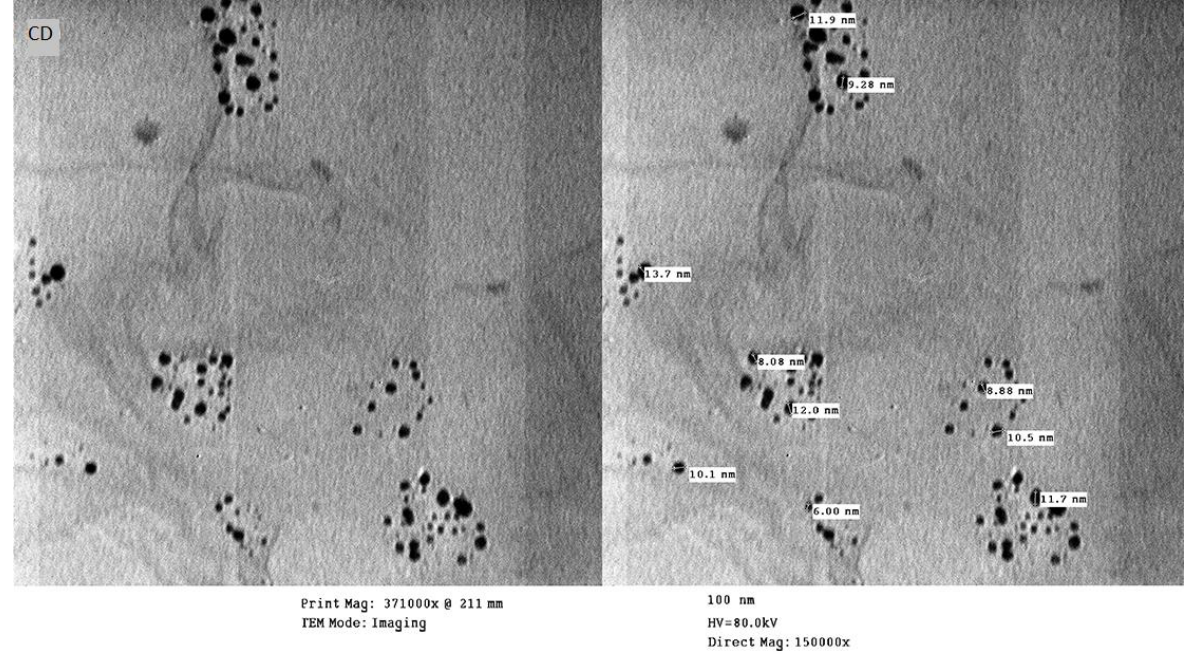
Fig. 5. Transmission electron microscope images of carbon dots